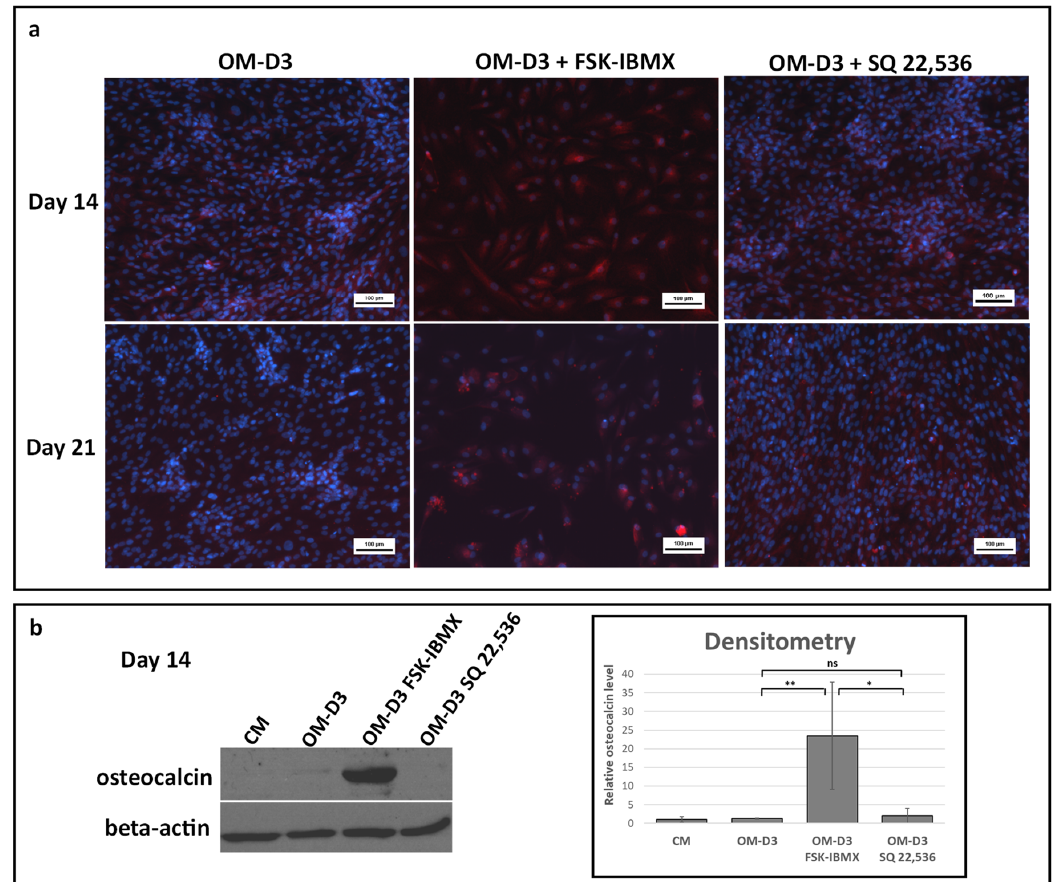
Figure 8. Effect of cAMP on late differentiation events after predifferentiation in spheroids—protein production. ADSCs predifferentiated in spheroids for 7 days in OM and differentiated for another 14 days on 2D TCPS (total differentiation time was 21 days) in OM-D3 with FSK–IBMX (FSK, 10 nM; IBMX, 500 nM) or SQ 22,536 (100 nM). ( a ) Osteocalcin protein stained with mouse monoclonal antibody and detected with goat anti-mouse Alexa Fluor 700 secondary antibody (red). Nuclei stained with Hoechst 33,342 (blue). ( b ) Western blot for osteocalcin and beta-actin performed at Day 14. Representative blot and densitometric analysis of osteocalcin level shown. Osteocalcin level was normalized to beta-actin. Mean from three independent experiments is shown; each experiment was performed on cells isolated from a different donor. Error bars represent standard deviation. *, p < 0.05; **, p < 0.01; ns, not significant.